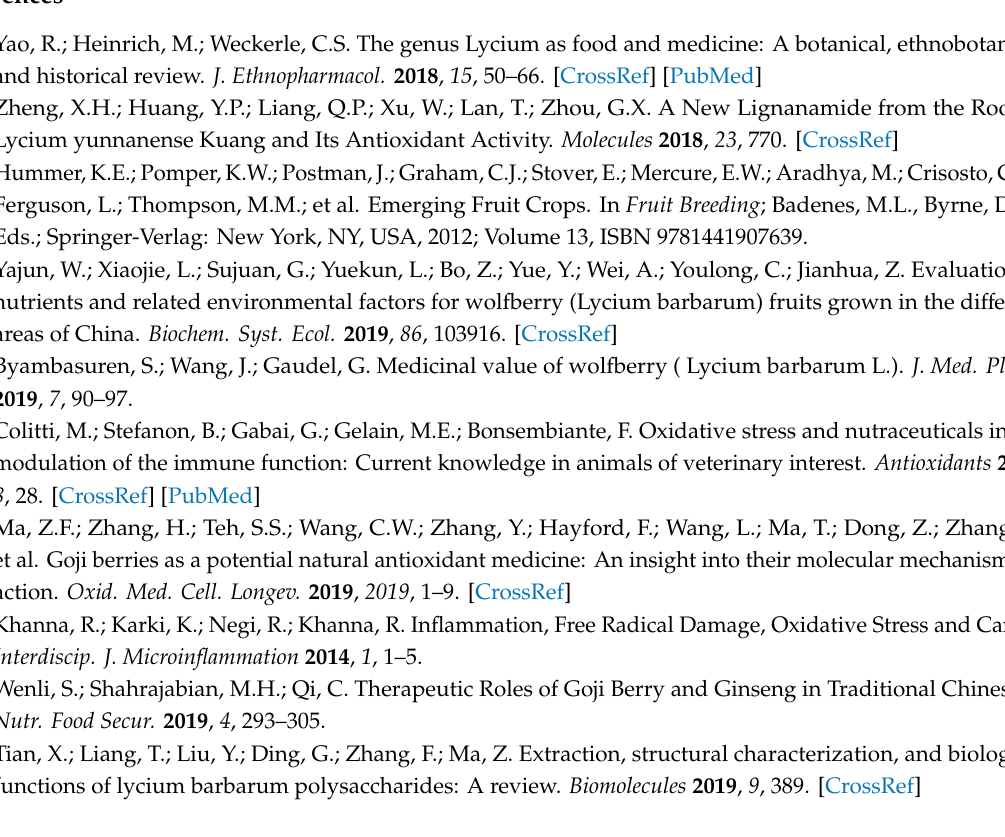
Figure S1 . Venn diagram depicting the shared and unique di ff erentially accumulated metabolites between pairs of wolfberry fruits samples from di ff erent planting areas. QF, NF and XF represent Qinghai, Ningxia and Xinjiang locations, respectively. Table S1. List of the metabolites detected in wolfberry fruits from di ff erent locations using the widely targeted metabolomics approach. QF, NF and XF represent Qinghai, Ningxia and Xinjiang locations, respectively. Mix represents the mixed samples used for quality control. Data represent the metabolite ion intensity. Table S2. List of the metabolites di ff erentially accumulated between pairs of wolfberry fruit samples from di ff erent planting areas. QF, NF and XF represent Qinghai, Ningxia and Xinjiang locations, respectively. Data represent the metabolite ion intensity. TRUE means significantly di ff erent while FALSE represents no significant di ff erence between pairs of